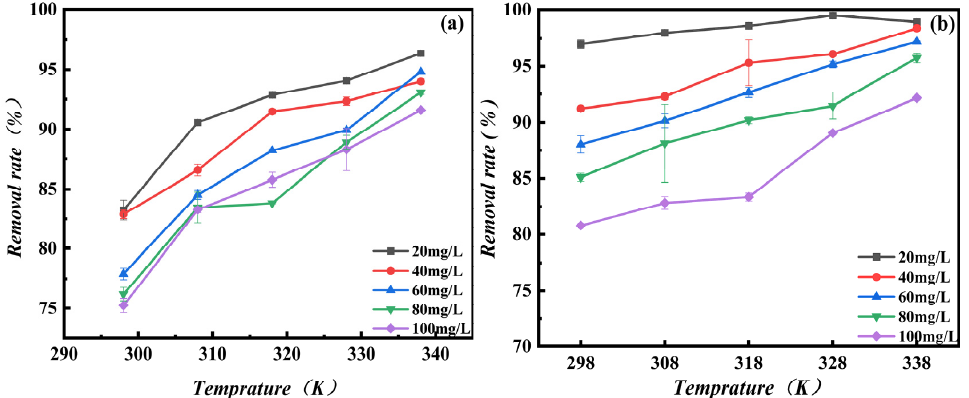
Figure 9. Effect of the temperature for the adsorption of MB onto BC ( a ) and Fe 3 O 4 -MOS ( b ) compo- sites at 20, 40, 60, 80and 100 mg/L dye solutions.